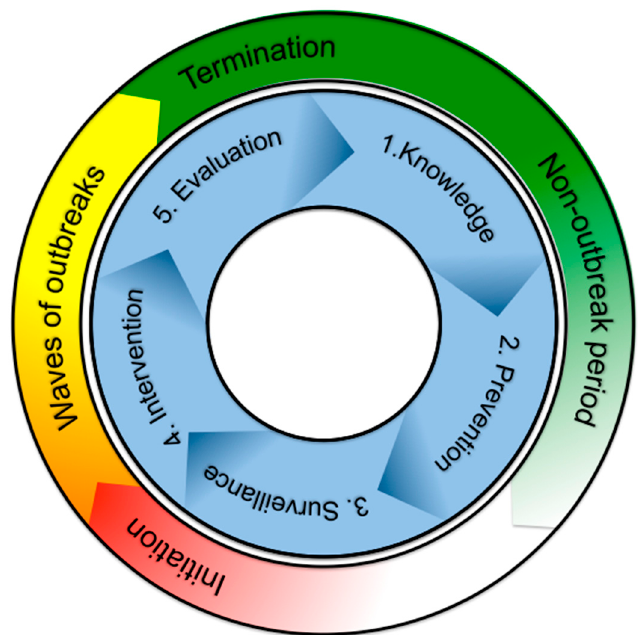
Figure 4. Key phases in the cycle of outbreaks of Acanthaster spp. relative to established phases in adaptive management cycles. To effectively manage and prevent future outbreaks, intensive surveillance and intervention are required at/or before the initiation of outbreaks. It is also critically important, that research and management continue throughout the non-outbreak period.